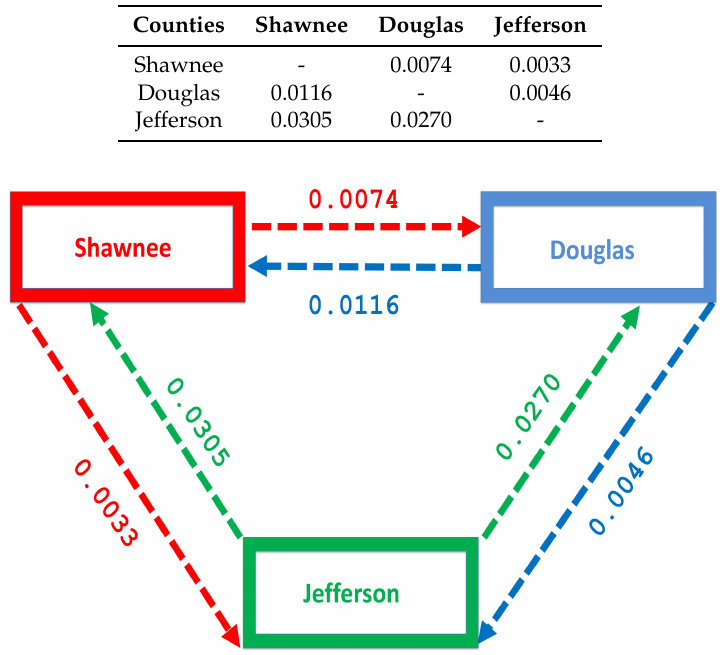
Table 5. County-to-county 2009–2013 ins-outs-nets-gross migration rate in Shawnee, Douglas, and Jefferson counties.